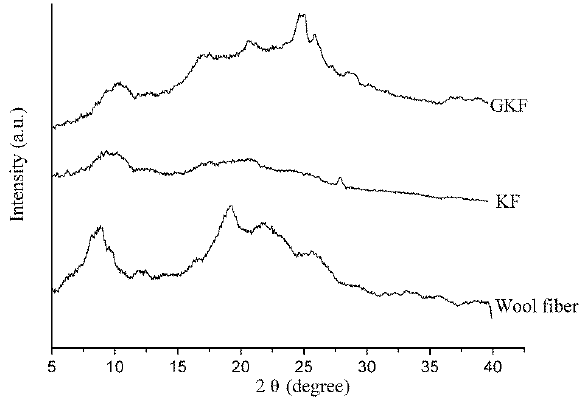
Figure 6. X-ray diffraction analysis of wool fibers and regenerated keratin samples.